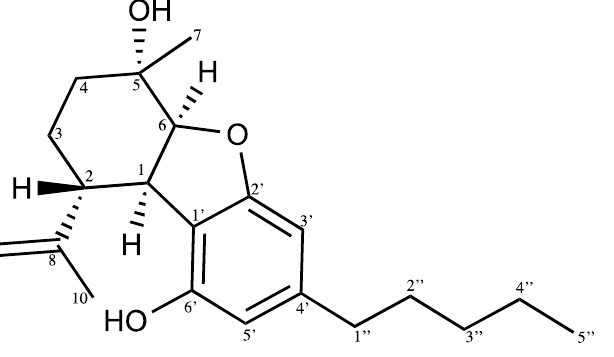
Table 2. Kinetic parameters of cannabinoid synthase orthologues.